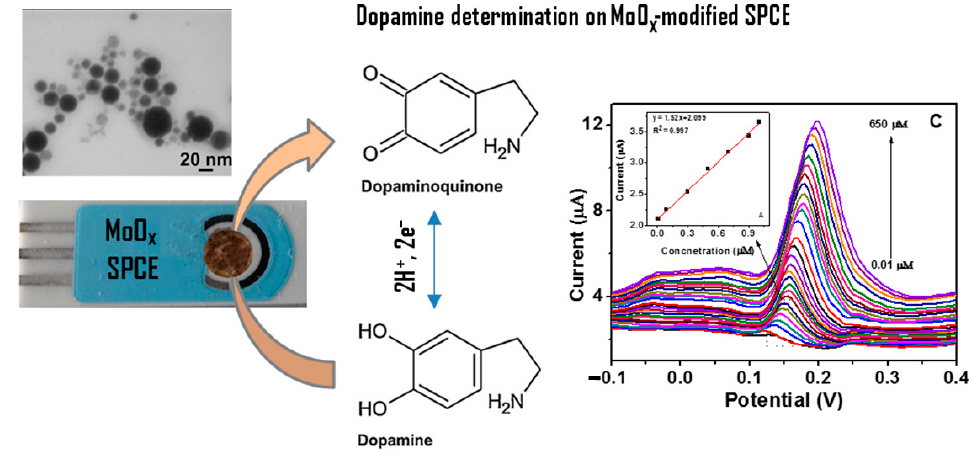
Figure 13. Schematic representation of dopamine electrochemical oxidation on the MoO x nanostructured modified screen-printed carbon electrode and square wave voltammetry (SWVs) for 0.01–650 μ M dopamine (DA) concentrations at MoOx/ screen printed carbon electrode (SPCE) in 0.1 M phosphate buffer saline solution. The inset shows the calibration curve at low DA concentration (0.01–1 μ M). Reprinted from Journal of Electroanalytical Chemistry, Vol 814, Fazio, E. et al., Molybdenum oxide nanoparticles for the sensitive and selective detection of dopamine, Pages No. 91–96, Copy- right (2018), with permission from Elsevier [130].